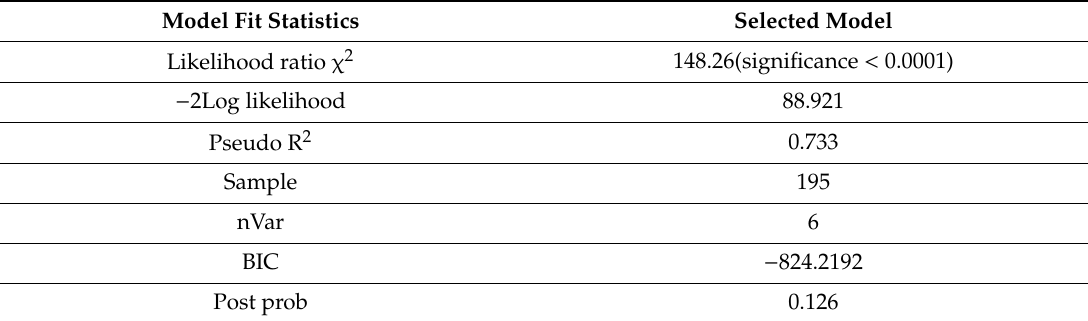
Table 3. Logistic regression goodness-of-fit measures.